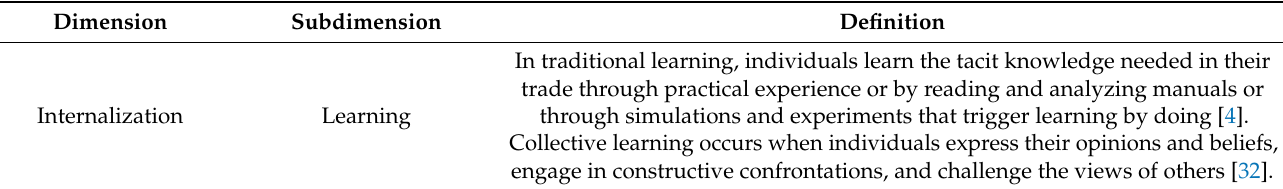
Table 4. The internalization dimension.